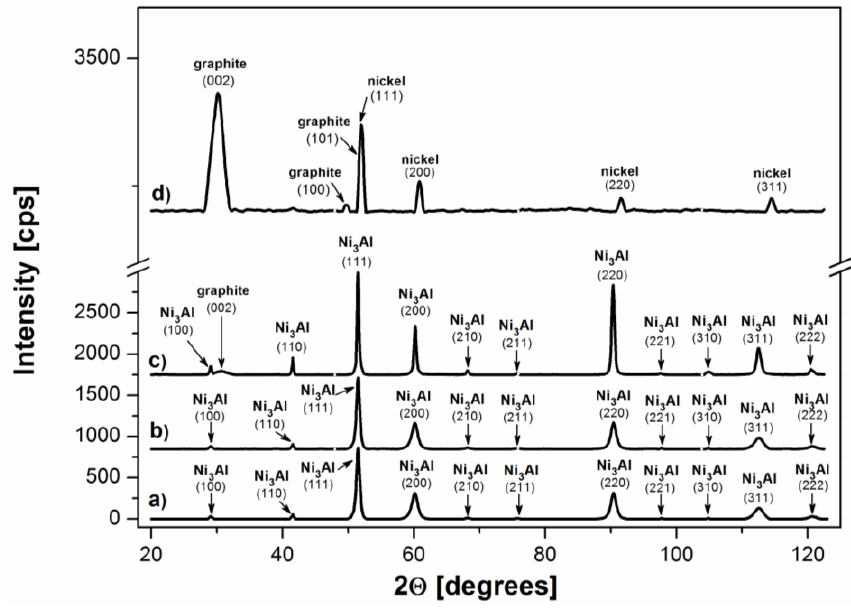
Figure 6. XRD patterns of Ni 3 Al foil surface: ( a ) before experiments; after cyclohexane decomposition at: ( b ) 500 °C and ( c ) 700 °C as well as deposit scraped off of the surface of Ni 3 Al foils ( d